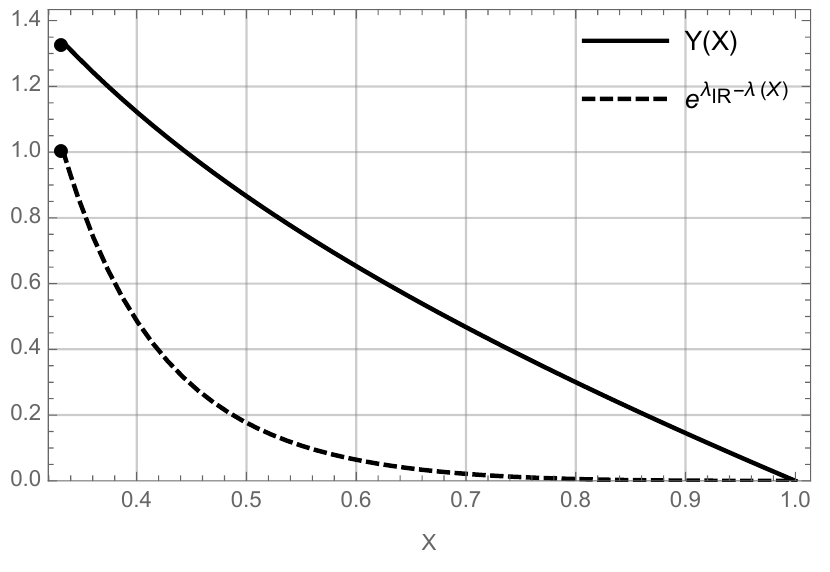
Figure 4 . A analytic solution in the case p = 1. The UV region is at X = 1, Y = 0 and the IR is indicated by the solid